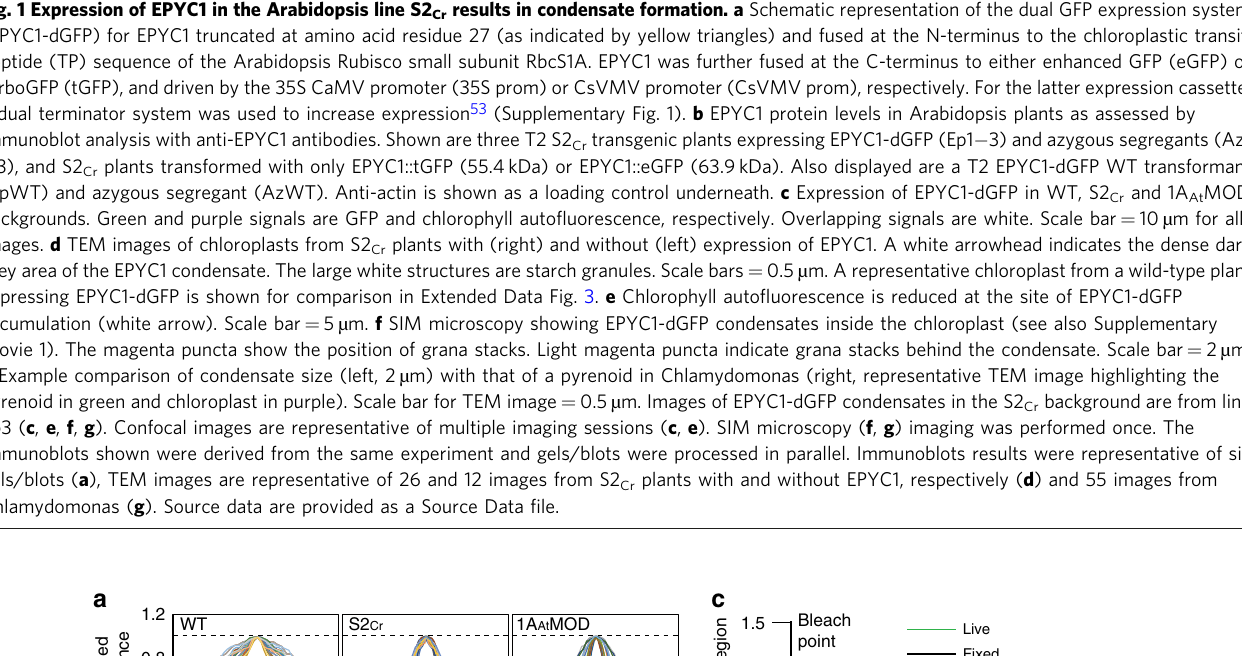
Fig. 2 In planta condensates behave like liquid − liquid phase-separated microcompartments. a Fluorescence distribution plots of EPYC1-dGFP across the chloroplast. The intensity of the GFP fl uorescence signal over the cross-section of a chloroplast is shown in WT ( n = 28), S2 Cr (line Ep3, n = 17) and 1A At MOD ( n = 22) backgrounds. Both GFP fl uorescence and cross-section values have been normalised to 1 (as indicated by the dashed line), with the highest value in the centre. b Fluorescence recovery after photobleaching (FRAP) assays. Condensates are shown from live (top) and fi xed (bottom) leaf tissue from S2 Cr transgenic line Ep3 expressing EPYC1-dGFP. Scale bar = 1 µ m for both images. c Fluorescence recovery of the bleached area in relation to the non-bleached area of condensates. The mean ± SEM are shown for live ( n = 13) and fi xed ( n = 16) chloroplasts. Source data are provided as a Source Data fi